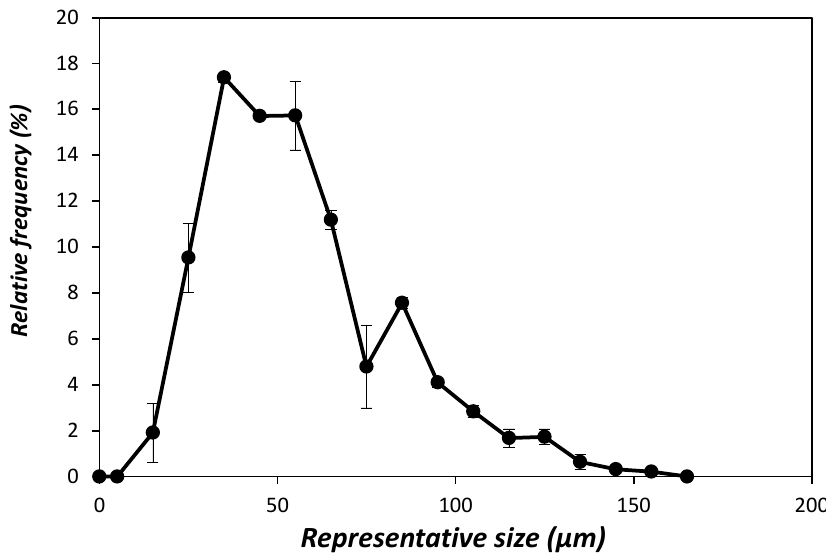
Figure 3. Crystal size distribution of gypsum seed crystals.